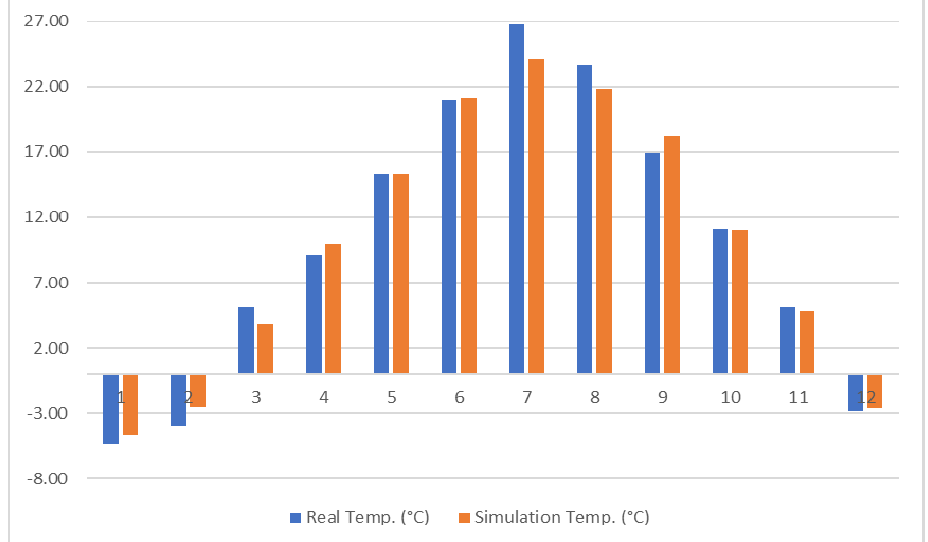
Figure 6. Mean Outdoor Temperature of Real Building and Simulation.